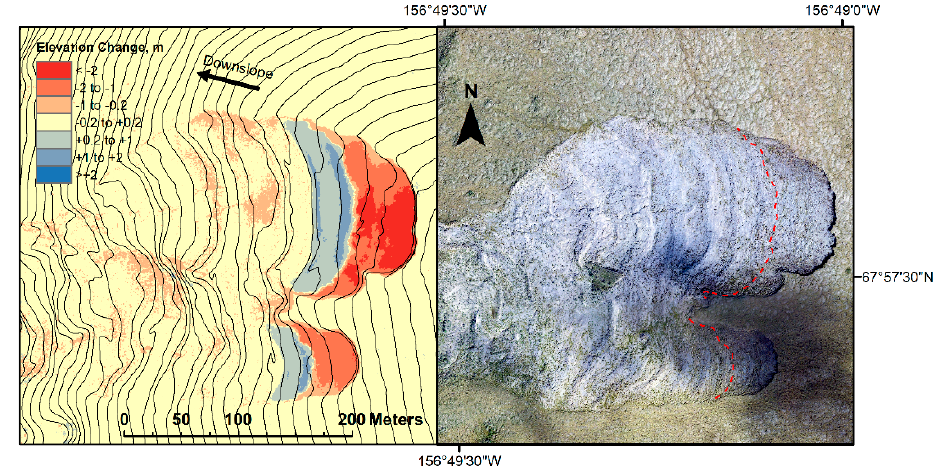
Figure 14. Retrogressive thaw slump NOAT070. The contour map on the left (1 m contour interval) shows elevations in 2016 and the elevation change from 16 September 2013 to 11 July 2016. The orthophotograph on the right is from 2016, with the 2013 scarp position noted. The volume change in the upper subsidence zone (red) was − 15062 m 3 and in the nearby deposition zone (blue) +4951 m 3 (33% of the subsidence volume). Remote Sens. 2018 , 10 , x FOR PEER REVIEW 19 of 24